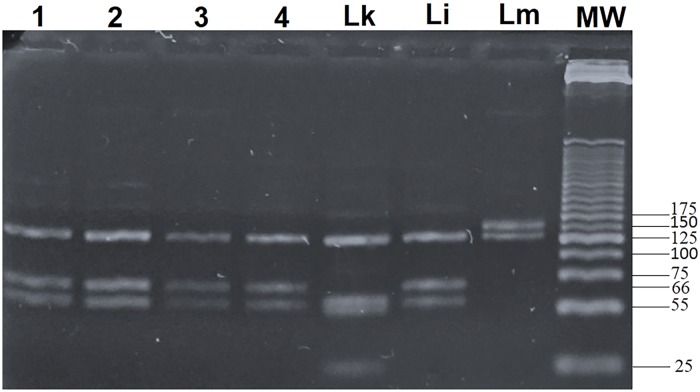
ITS1 nested PCR-RFLP results.The Leishmania species typing using RFLP was done for the 54 PCR-ITS1 positive samples. The specific molecular band sizes are: 127, 55, 52, and 20 bp for L. killicki; 126, 66, and 55 bp for L. infantum; 145 and 126 bp for L. major. Lanes 1, 2, and 3: L. infantum identified from infected Ph. perfiliewi, Lane 4: L. infantum identified from infected Ph. perniciosus, Lk: L. killicki control, Li: L. infantum control, and Lm: L. major control. MW: Molecular Weight marker (25-bp DNA ladder).